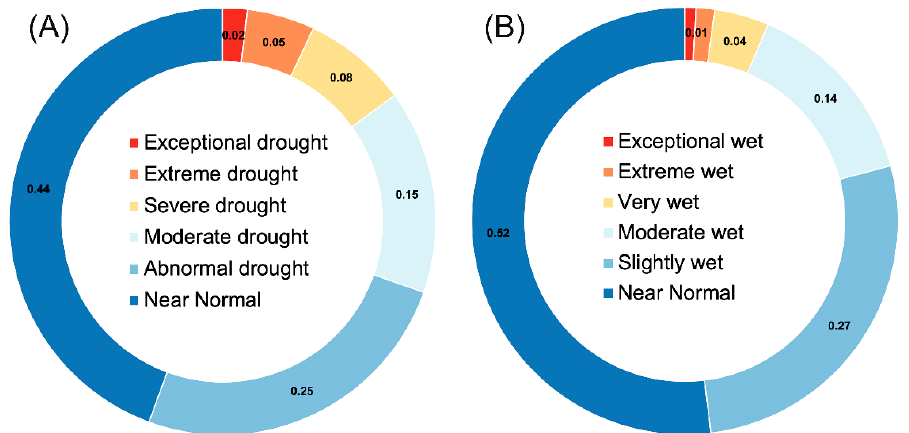
Figure 15. Exceedance probabilities of hydrological extremes, drought ( A ) and flooding ( B ), from 1901–2050.